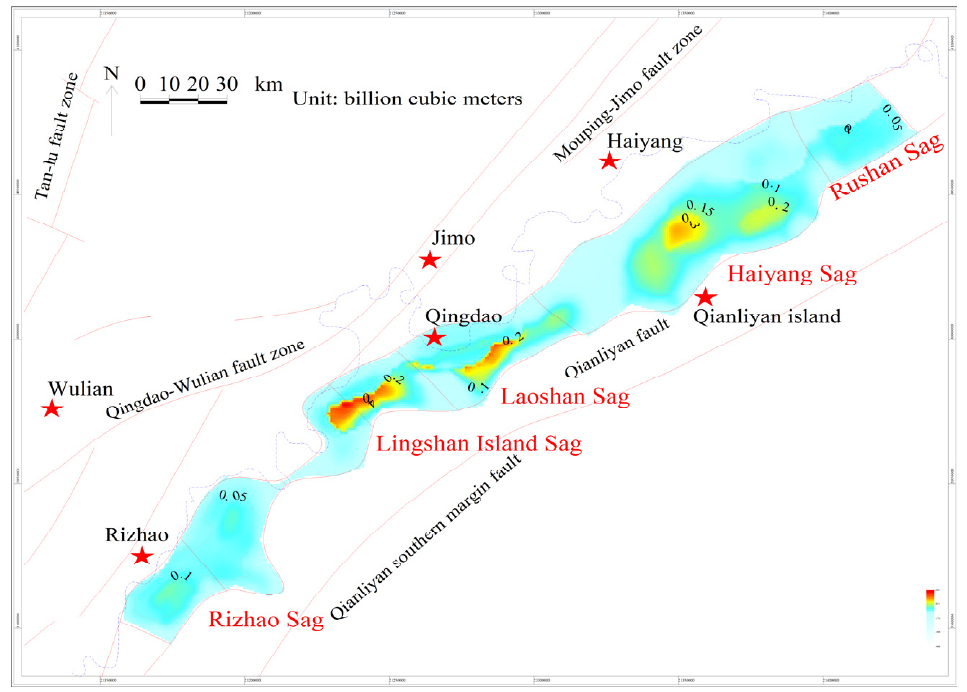
Figure 13. Contour map of total resources in Ri-Qing-Wei Basin.